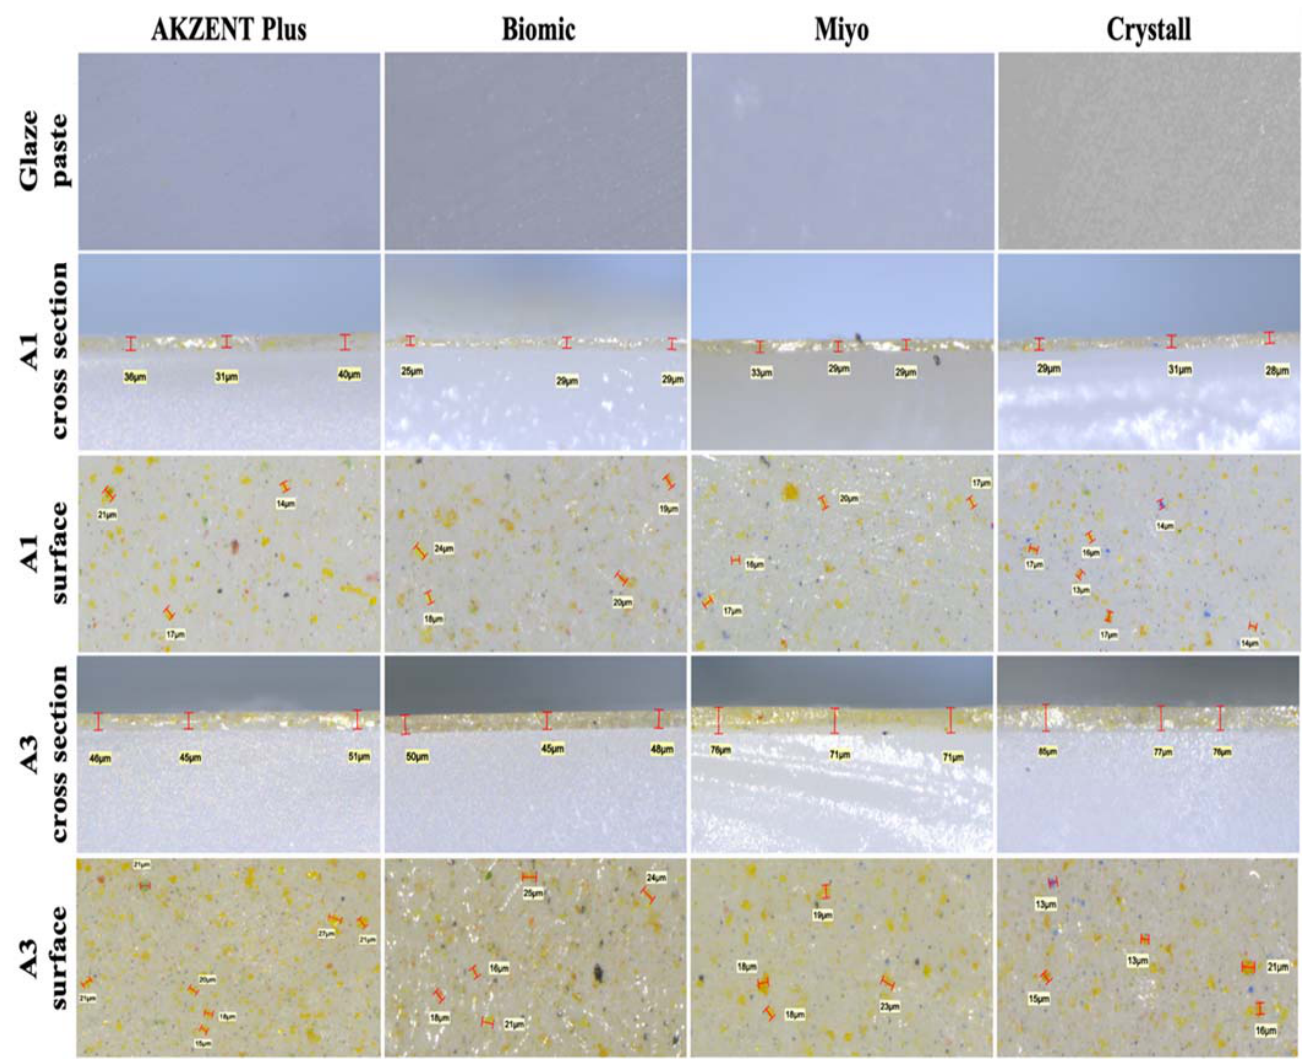
Figure 6. Thickness of the staining layer.